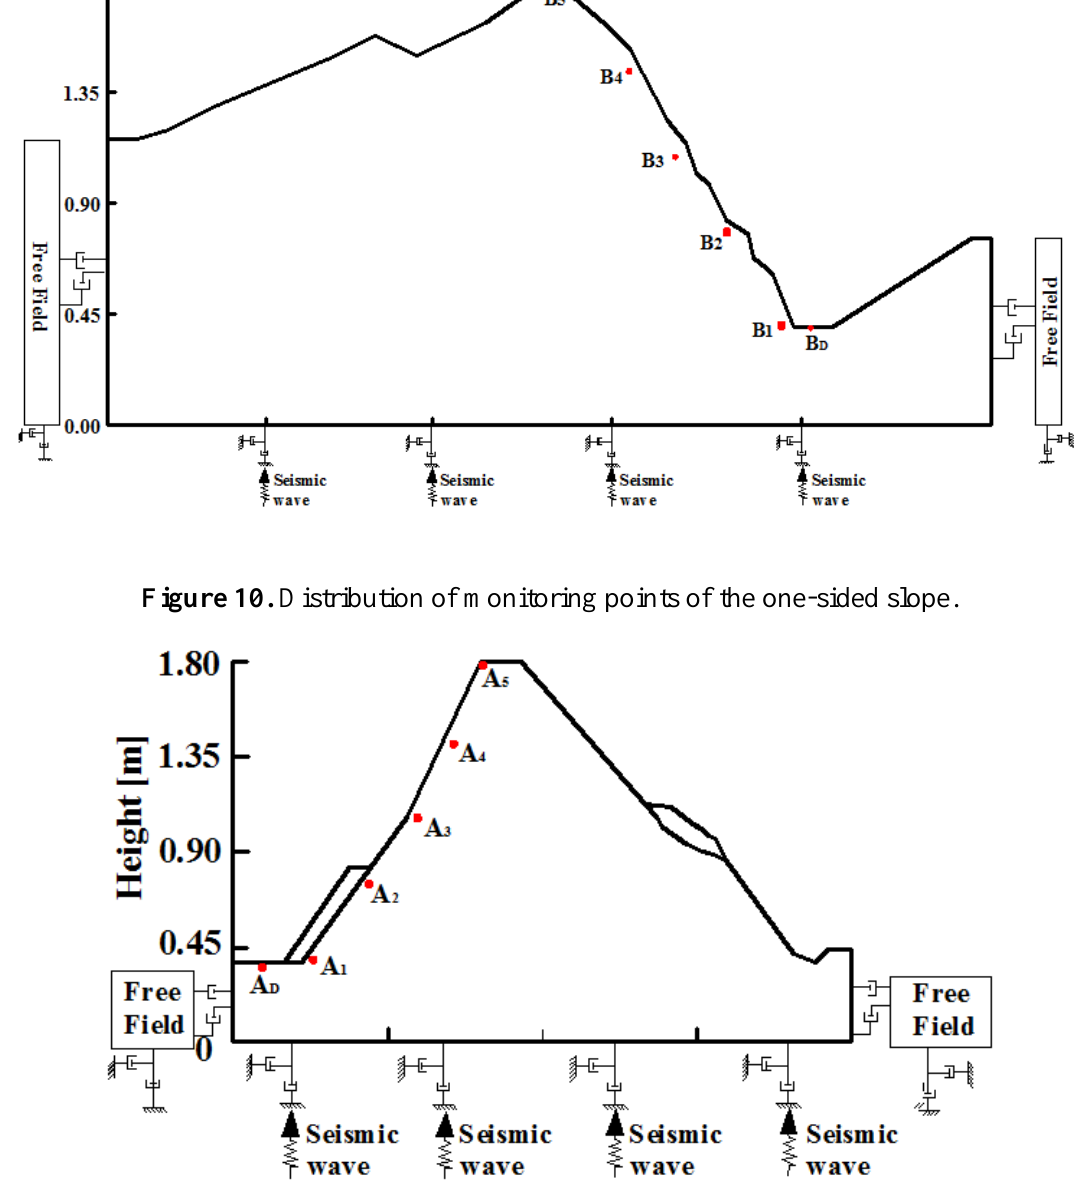
Figure 11. Distribution of monitoring points on the two sided